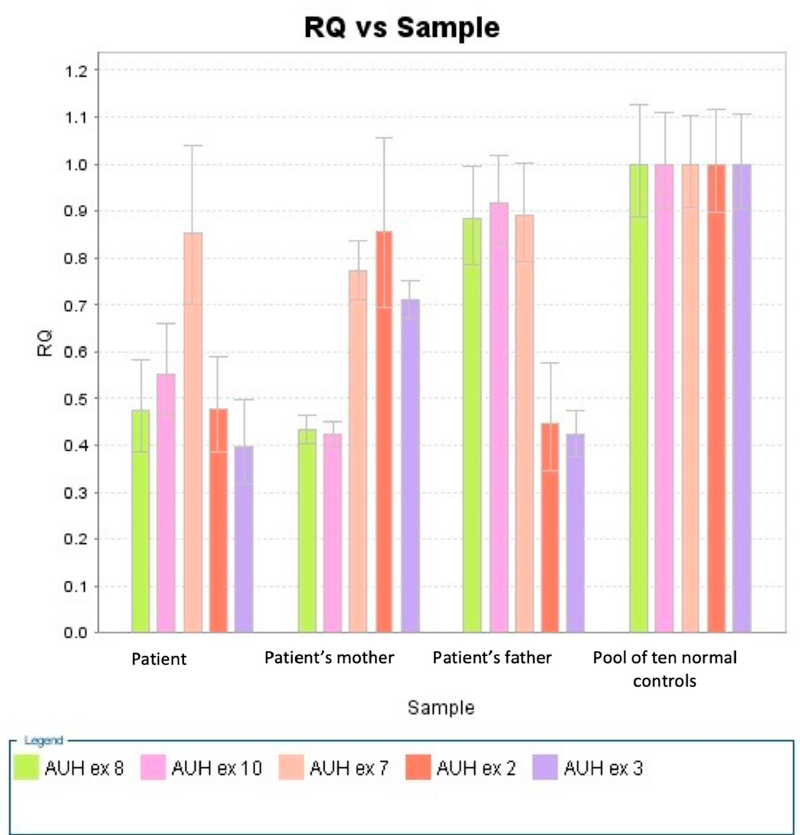
Figure 3. Relative quantification (RQ) values of AUH exons by sample.